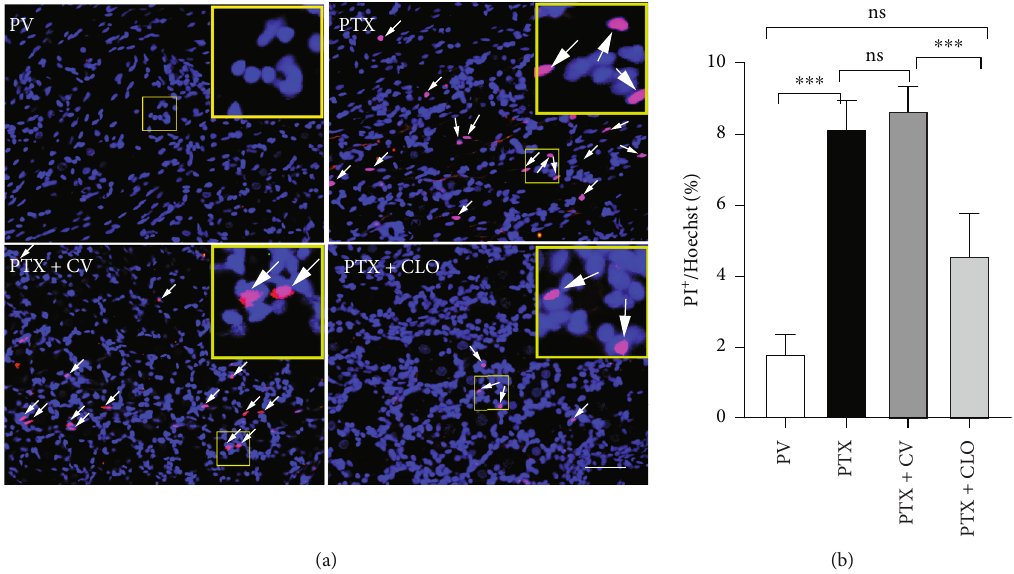
Figure 6: Neuronal necrosis of the DRG in rats with PIPN evaluated via PI/Hoechst staining. (a) Microphotographs of in vivo PI labeling in the DRG on day 14. (b) Quanti fi cation of PI-positive cells ( scalebar = 50 μ m ). Data are expressed as the mean ± SD ( n = 6 in each group). The results were analyzed via one-way ANOVA followed by the LSD post hoc test. Asterisks indicate signi fi cant di ff erence between two groups at ∗∗∗ P < 0 : 001 ; ns: no signi fi cant di ff erence. Abbreviations: PI: propidium iodide; PTX, paclitaxel; CLO, clodronate disodium